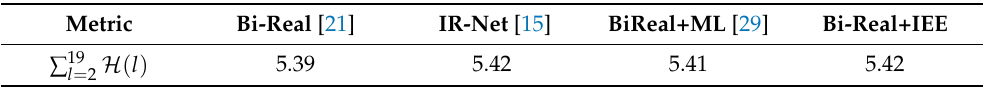
Table 2. Comparison with other related works on increasing information entropy of binary weights. We run all the models three times and report the mean information entropy on the CIFAR-10 test dataset. The evaluation metric is defined as the summation of the information entropy of binary weights in all the binary convolutional layers.